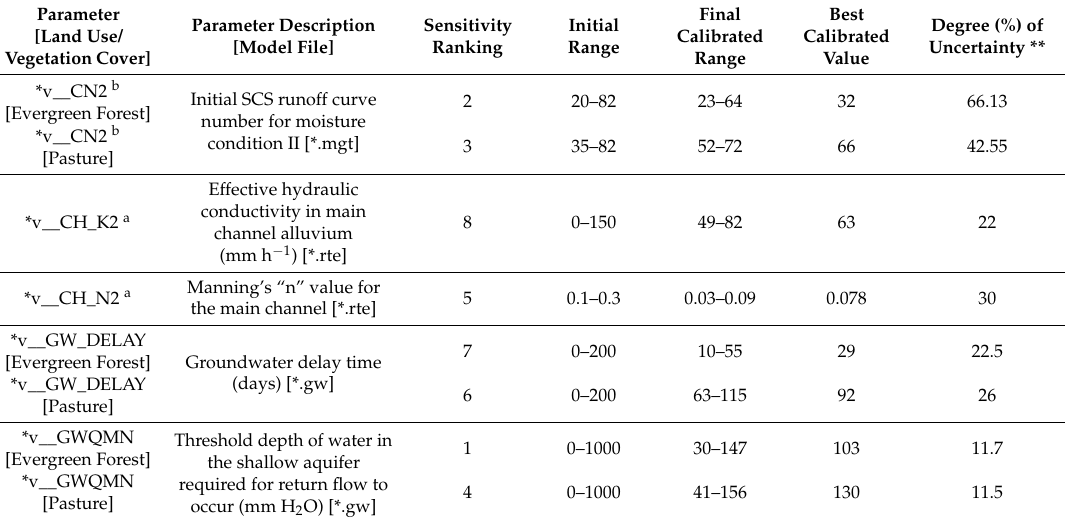
Table 2. SWAT parameters modified in the automatic calibration